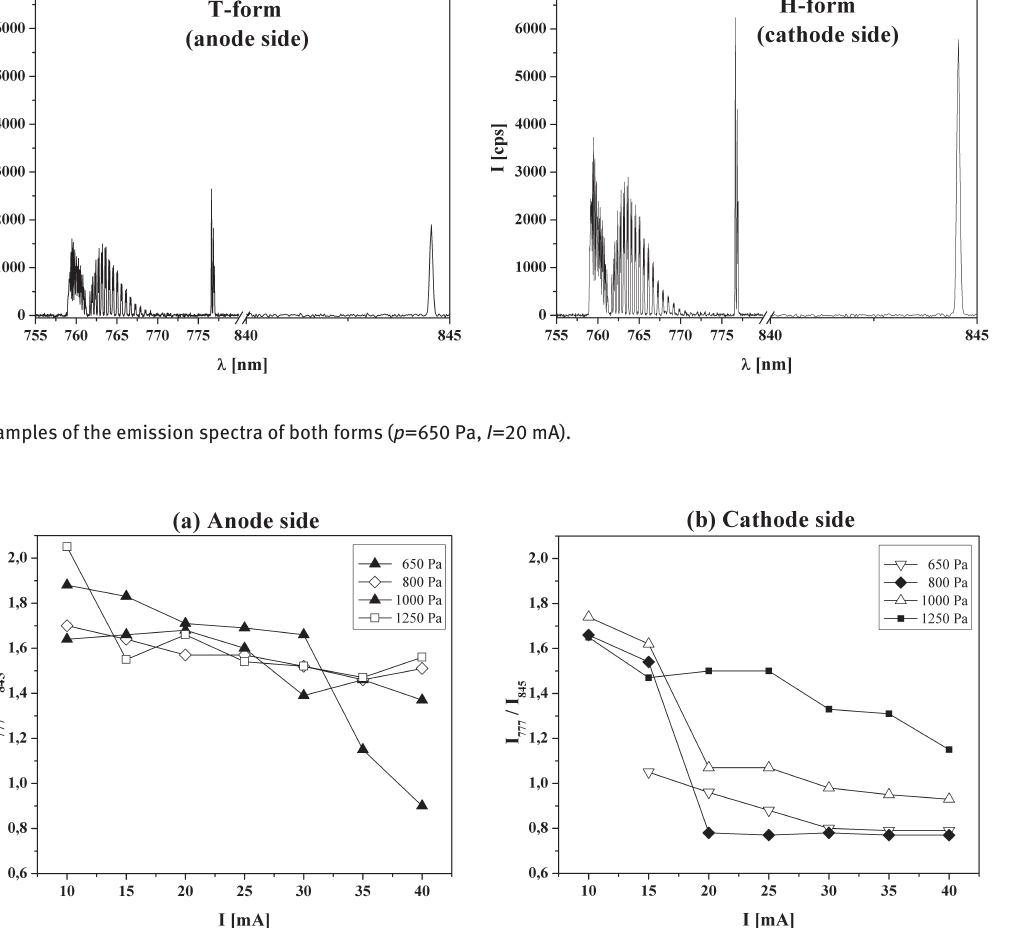
Figure 4: Relative intensity of the atomic oxygen lines I total pressure, which is closely connected to the occurrence of different forms of positive column of DC glow discharge.